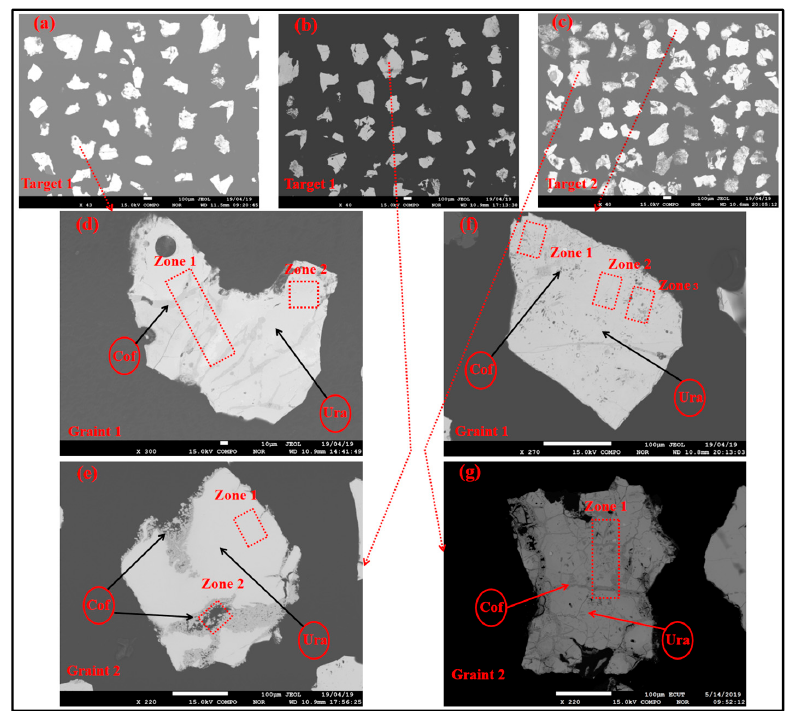
Figure 4. BSE ( a – g ) photomicrographs of typical uraninite from the MHK uranium deposit. ( a , b ) Viewshed map of Target 1. ( c ) Viewshed map of Target 2. ( d , e ) Typical grains of Target 1. ( f , g ) Typical grains of Target 2. “Ura” and “Cof” represent uraninite and coffinite, respectively. The analysis regions are shown in red rectangles for EDS mapping.